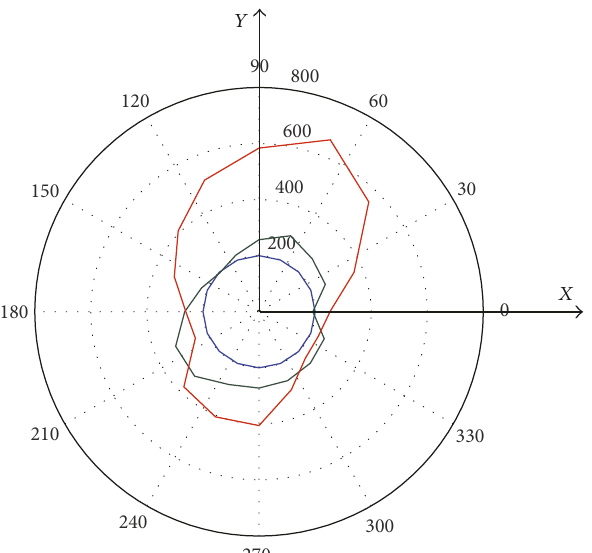
Figure 3: Pads clearances ( 𝜇 m) in the upper journal bearing of a LHG: (a) nominal clearances (blue circle), (b) clearances measured at 0 MW (green closed curve), and (c) clearances measured at 700 MW (red closed curve).